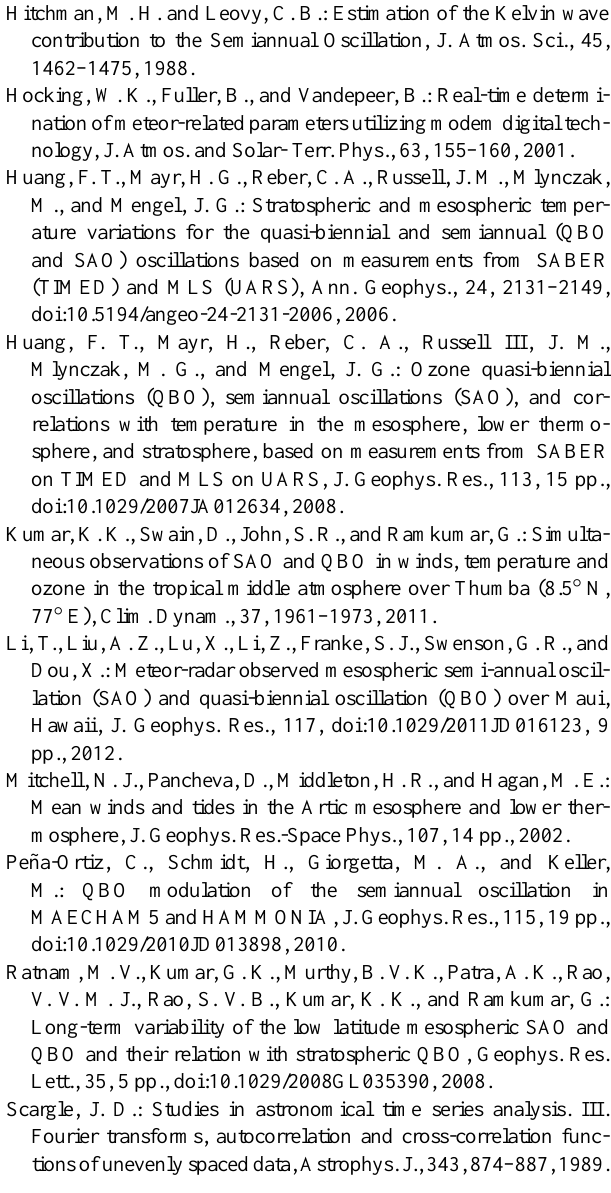
indicate a strong coupling between the winds of the meso- sphere and the